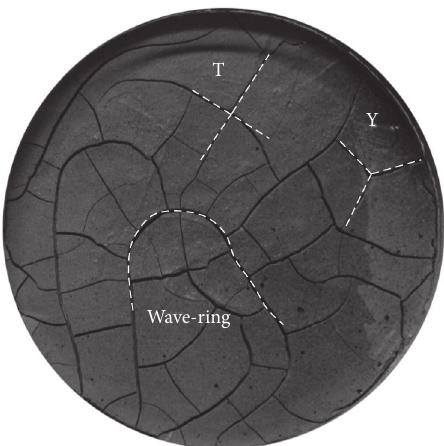
Figure 14: Different crack patterns observed in loess.